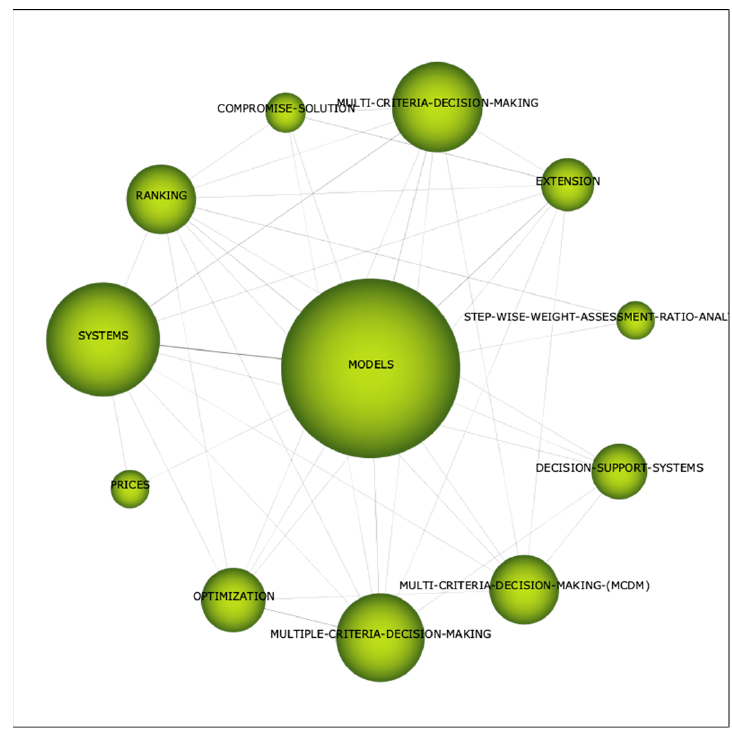
Figure A2. Model cluster network.